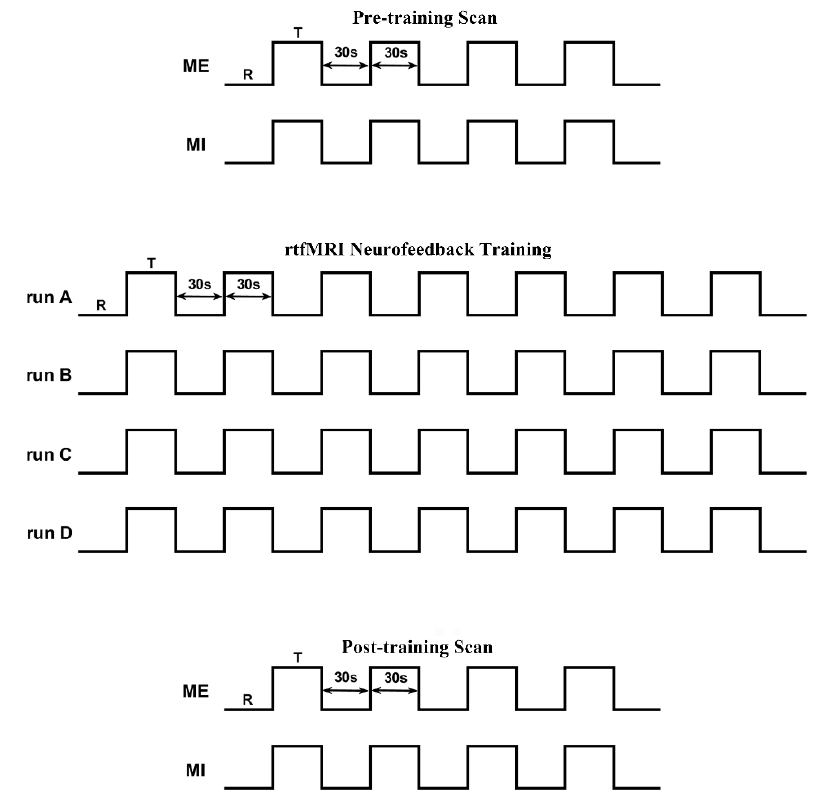
Figure 1. The diagram of the fMRI experiment.